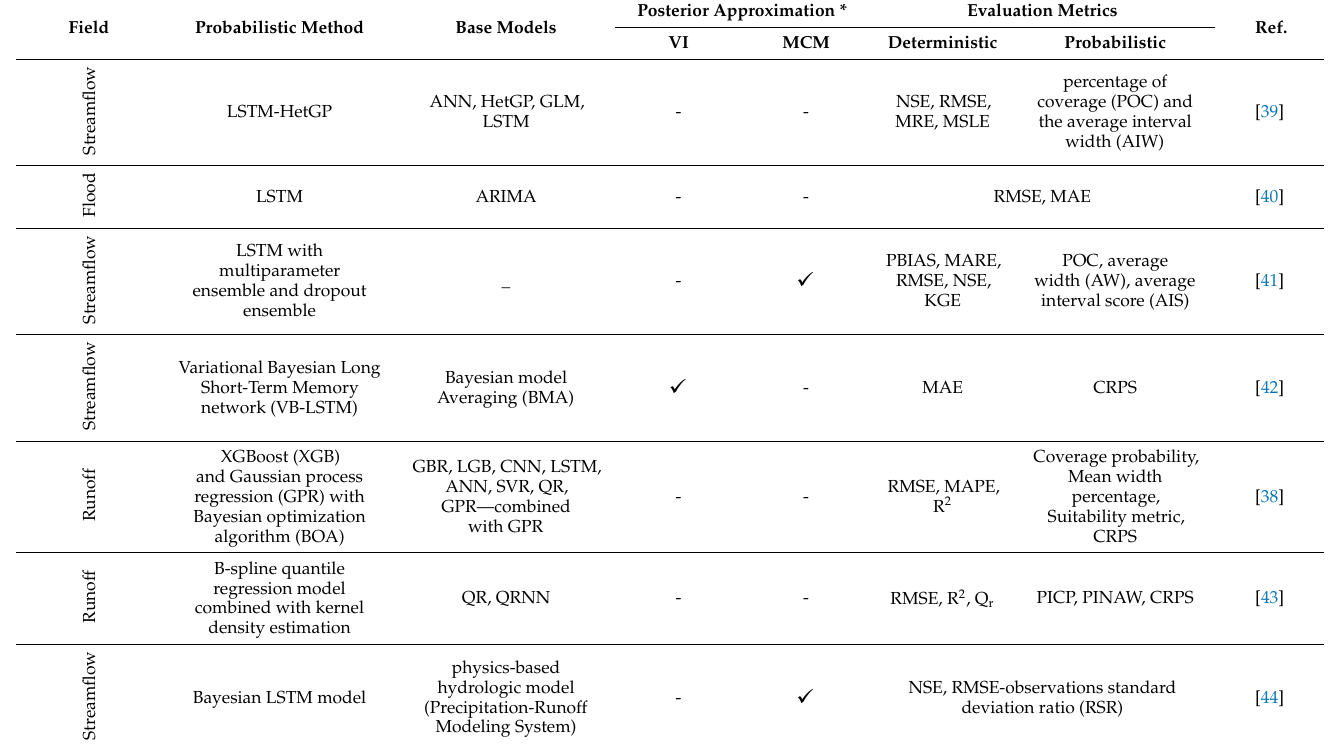
Table 1. Overview of recent probabilistic prediction studies in the field of hydrology.